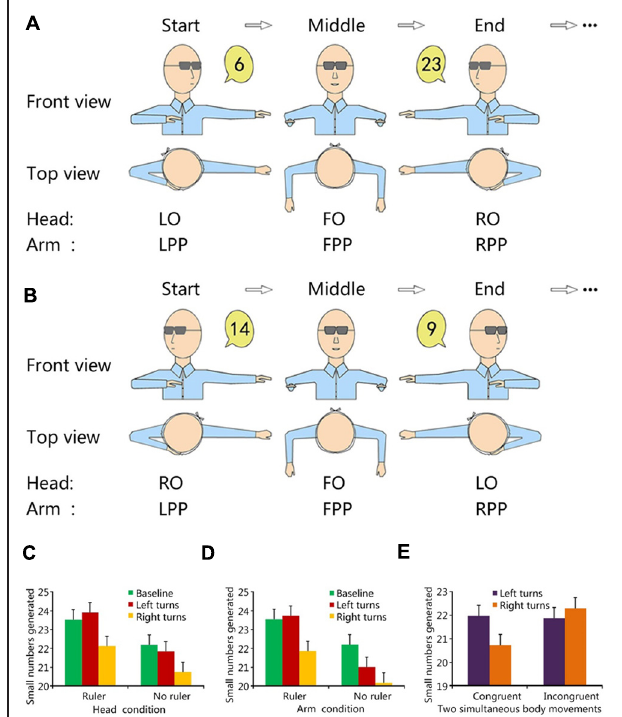
FIGURE 1 | Experimental approach and results of Experiments 1 and 2. (A) Congruent condition in Experiment 2. (B) Incongruent condition in Experiment 2. Note, Experiment 1 used a similar approach as in Experiment 2 except that the arm turns and the head turns were in different conditions. The start, middle and end postures of one lateral head/arm turn were labeled. Two perspectives, i.e., Frontal view and Top view, were used. (C) Results of the head turn condition in Experiment 1. (D) Results of the arm turn condition in Experiment 1. (E) Results of Experiment 2 (The ‘Left turns’ and ‘Right turns’ refer to the lateral turns with their directions defined by the head turns). Error bars are within-subjects SEs (Cousineau, 2005). LO, left orientation; FO, front orientation; RO, right orientation; LPP, left pointing position; FPP, front pointing position; and RPP, right pointing